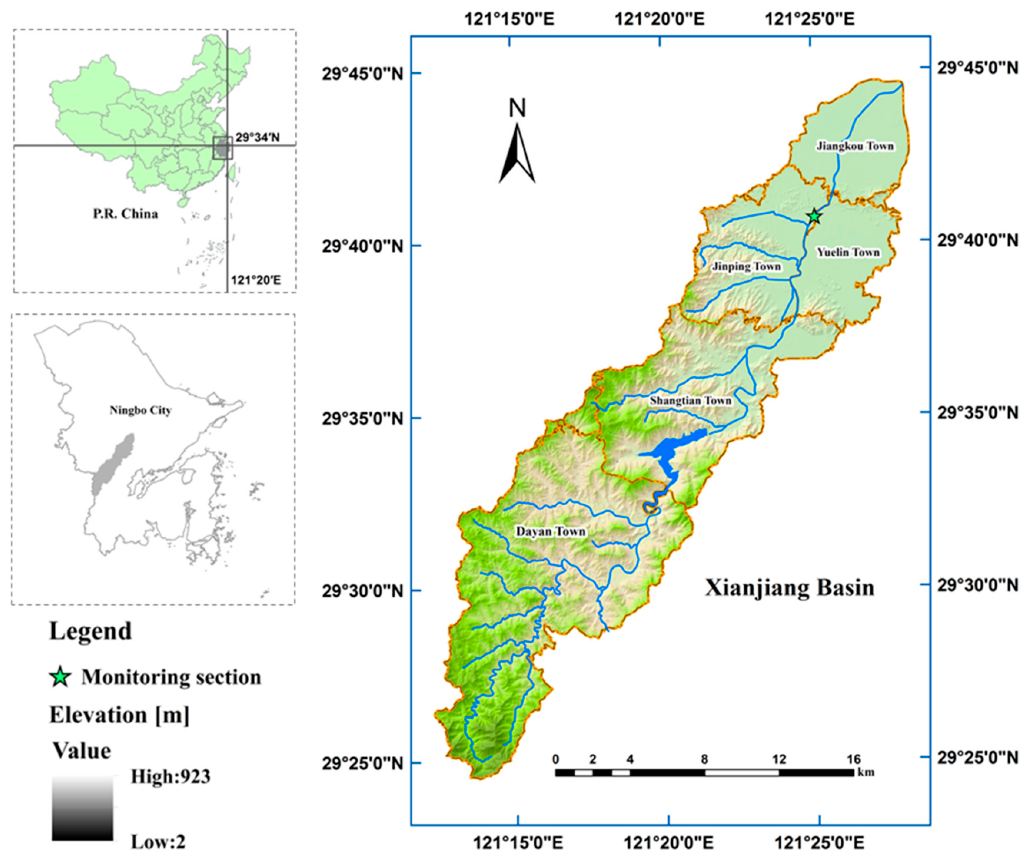
Figure 4. The geographic characteristics of Xian-jiang watershed within Ningbo City, China.